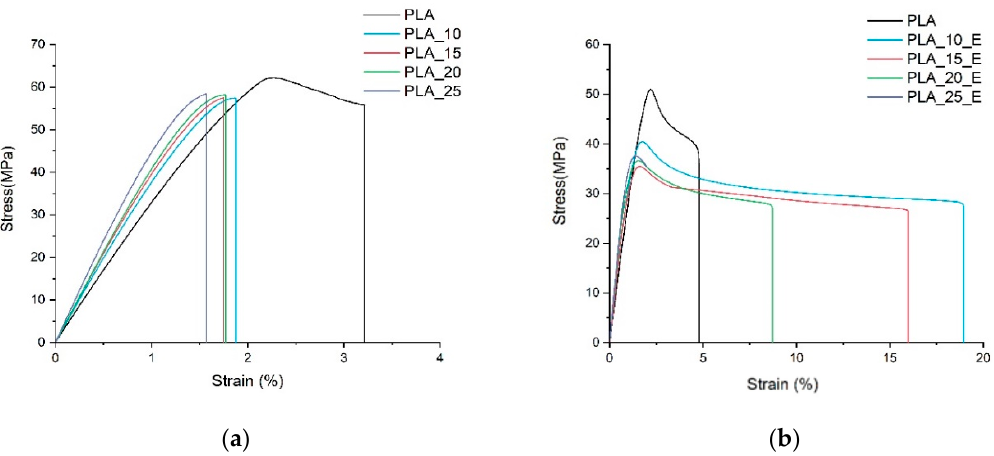
Figure 1. Stress-strain representative curves for pure PLA and for PLA/Arbocel fiber composites containing fibers content from 10 to 25 wt.%: ( a ) Composite system without additive, ( b ) composite system with the Einar addition.